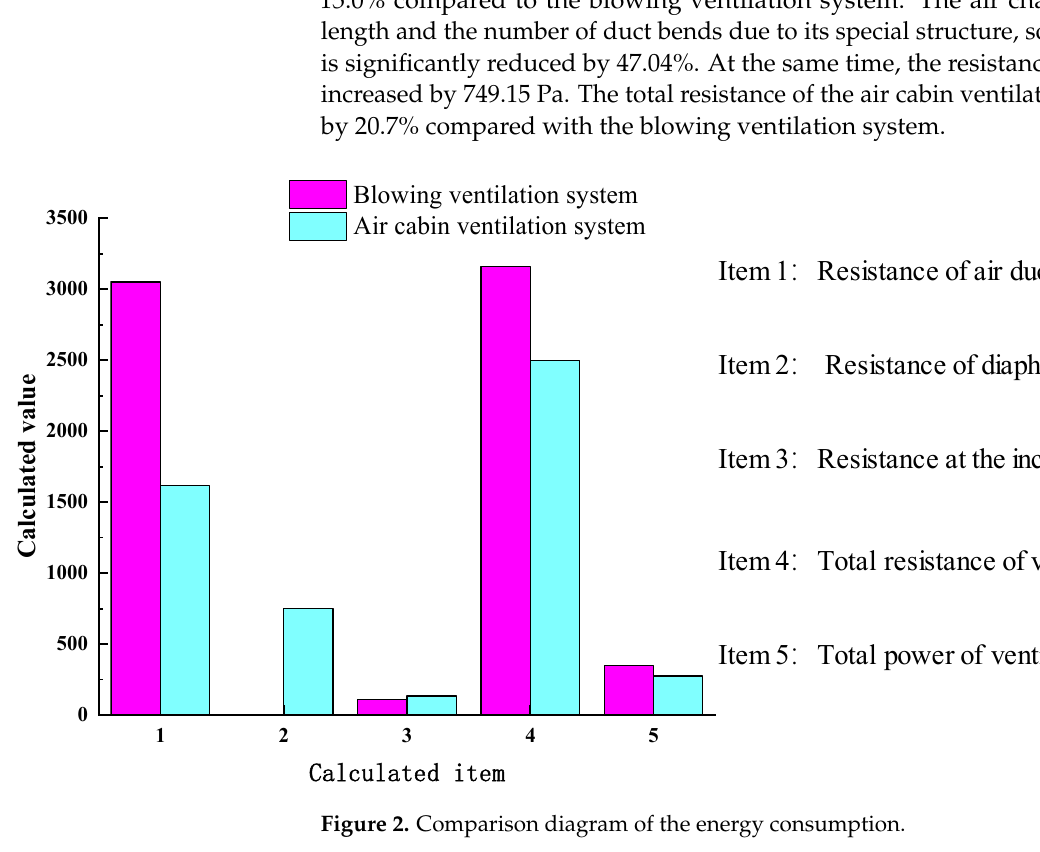
Figure 2. Comparison diagram of the energy consumption.